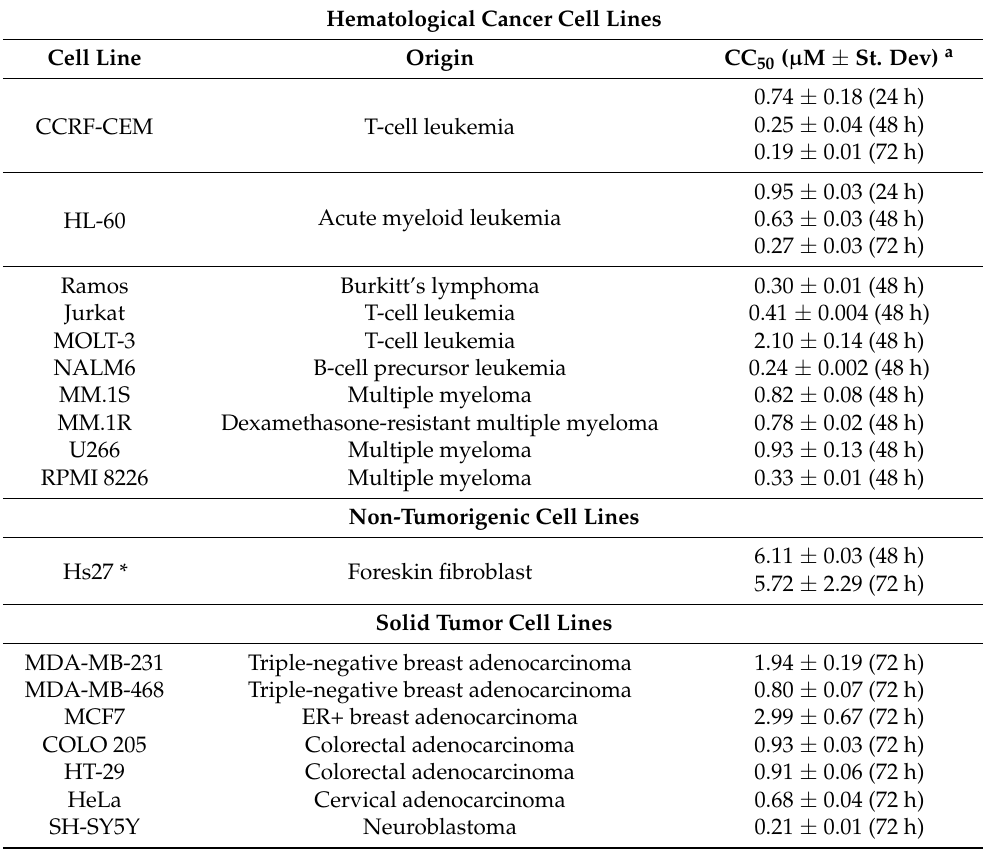
Table 1. Cytotoxic concentration 50% (CC 50 ) of Tpz-1 in a panel of 17 cancer and 1 non-cancerous cell line at 24 h (top), 48 h, and 72 h (bottom) of